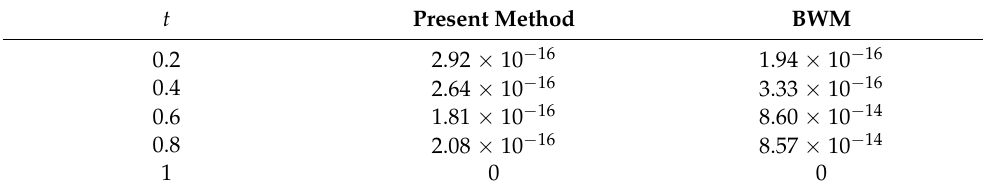
Table 3. The absolute error results obtained by the proposed method and the method of [44] where τ =